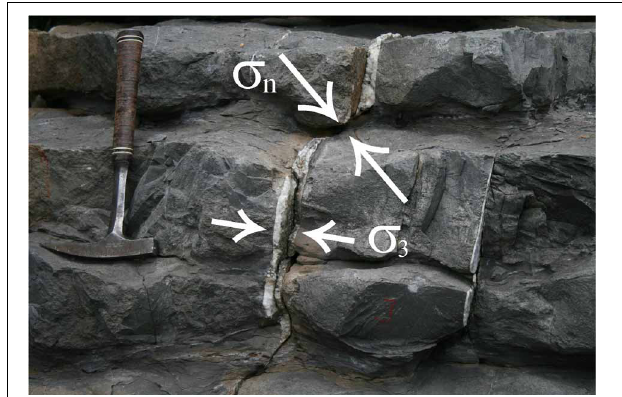
FIGURE 15 | Aperture variation of a calcite vein at Kilve, Somerset Coast. In the gray limestone layer, the vein is a vertical extension fracture, with the minimum principal compressive stress σ 3 as its normal stress (as is indicated by arrows). In the marl layer, however, the vein is an inclined shear fracture, subject to a higher normal stress σ n and therefore thinner than the vertical part. View north; the hammer provides a scale (cf. Brenner and Gudmundsson,